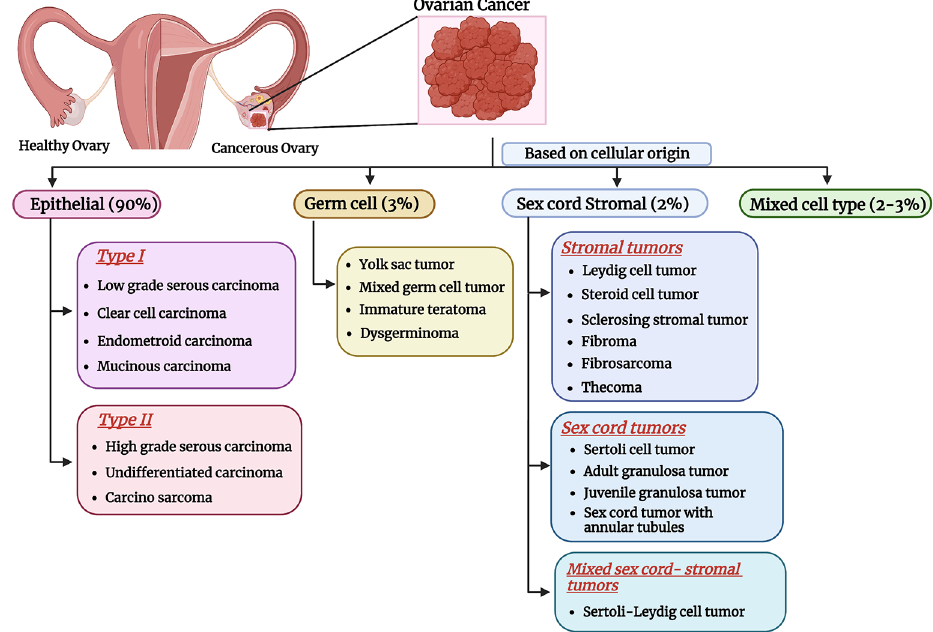
Figure1.ClassificationofOC. OCisbroadlyclassifiedintoepithelial,germcell,sexcordstromalandmixedcelltypes basedoncellularorigin,andsubclassifiedbasedonthesiteoftumoroccurrenceandmutationalstatus(createdwith